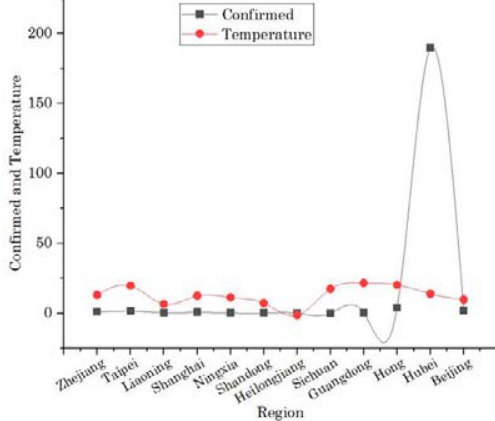
Fig. 3. Cluster results on the effect of Temperature on confirmed cases by COVID-19.